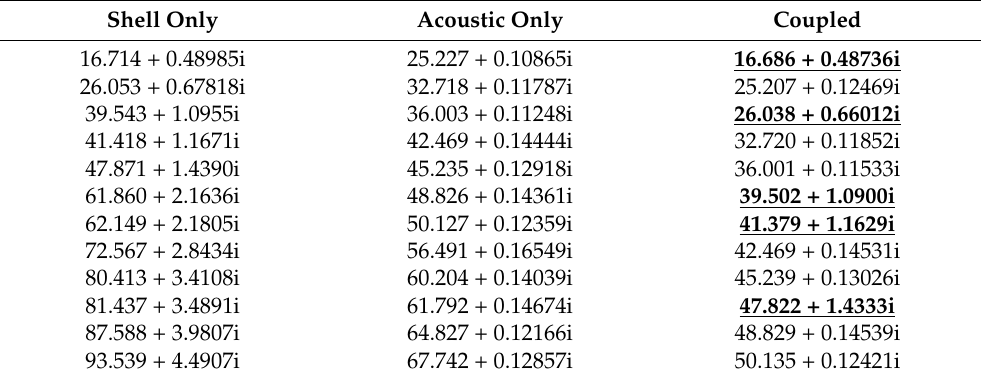
Table 3. Eigenvalues of vibration mode, acoustic mode from measured data, and mode generated by coupling effect. Bold-underline means eigenvalues made from coupled